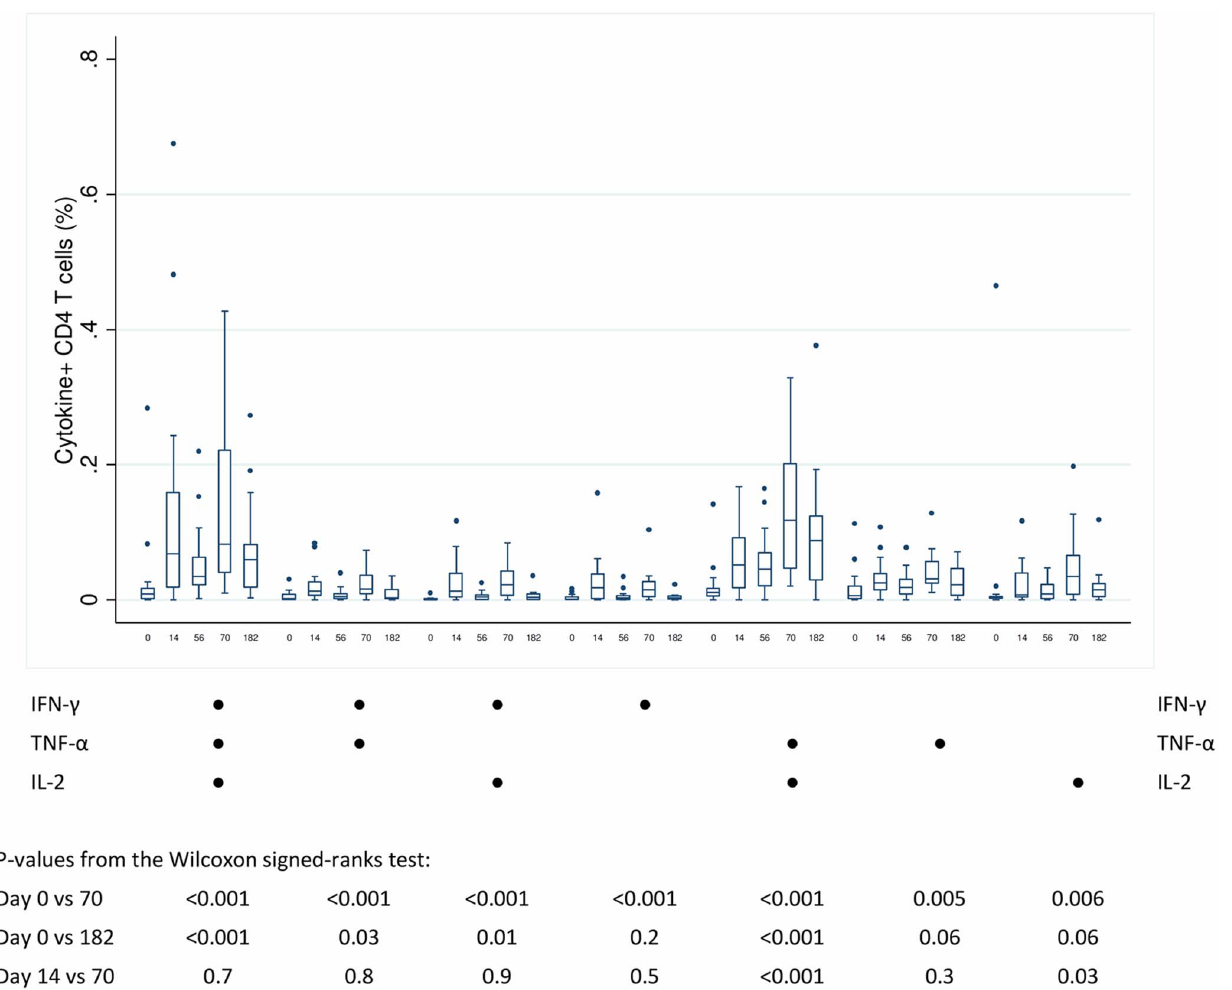
Fig. 6. Frequencies of H1 specific CD4 + Tcells expressing any combination of IFN- c , TNF- a and IL-2 at day 0, 14, 56, 70 and 182 in the vaccination group [unstimulated frequencies have been